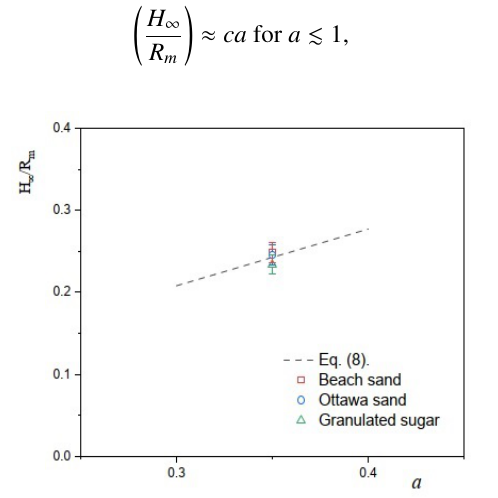
Figure 6. Plot of H ∞ / R m as a function of a (Eq. (8)). Data correspond to the materials used in our experiments with a = 0 . 35, meanwhile the prefactor c has a mean value c = 0 . 69 in order to embrace the respective values of c for the several